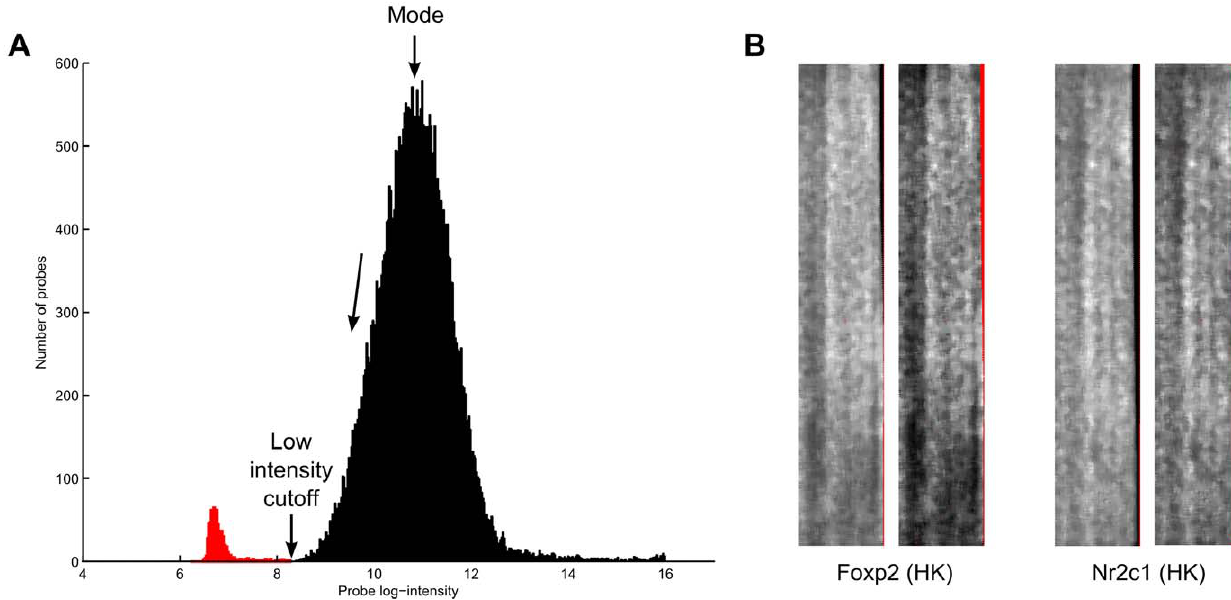
Figure 4. Low intensity probe filtering. (a) A filter cutoff point is determined based on the intensity histogram. (b) Two examples of how low intensity filtering successfully removes dark edge artifacts in PBM samples. In both samples pairs, the original sample is on the left, and the filtered sample on the right. Red pixels indicate missing or discarded intensity values.